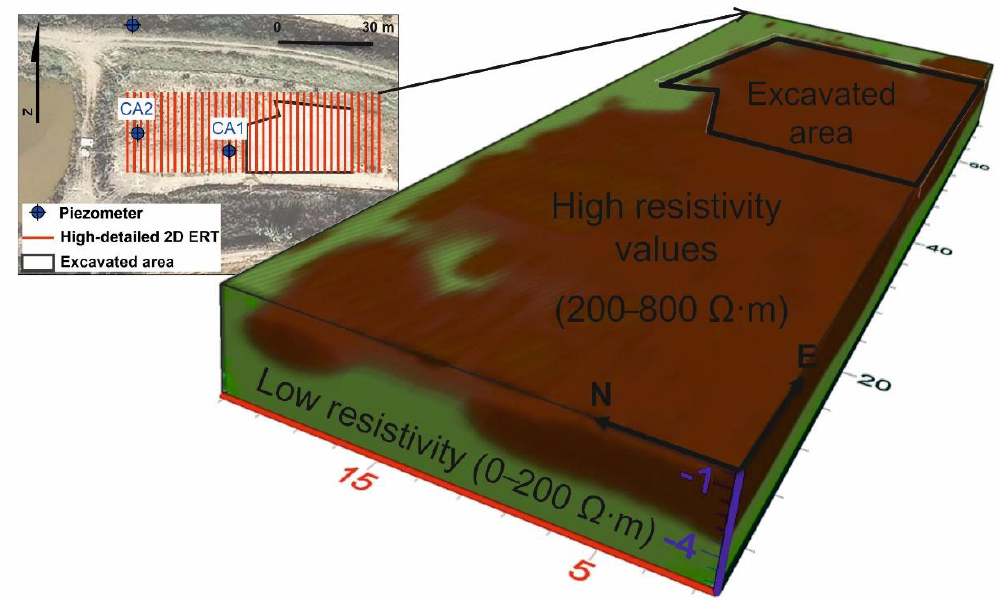
Figure 12. Three-dimensional image with the inverted electrical resistivity values obtained from the 38 high-detailed 2D ERT profiles at the infiltration pond of Ca n’Albareda. Distances are in